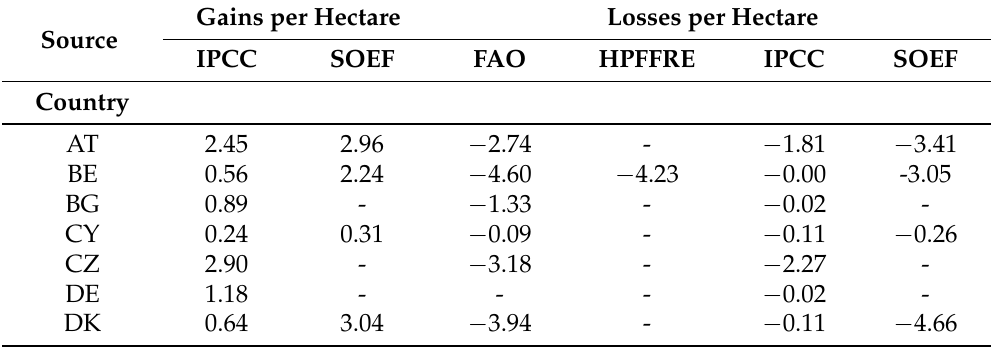
Table A3. Average gains and losses in tons of carbon per hectare over the data period